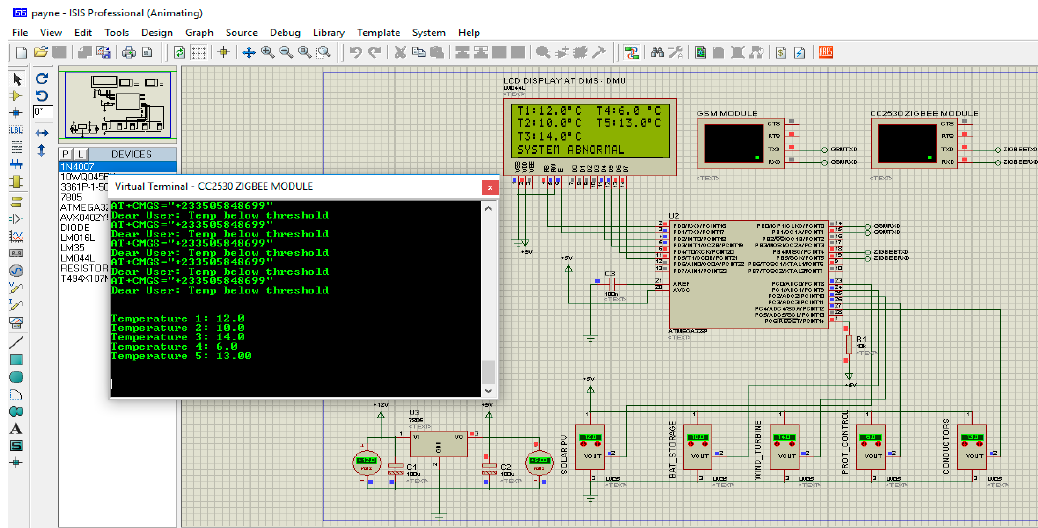
Figure 10. System abnormal condition below minimum settings.